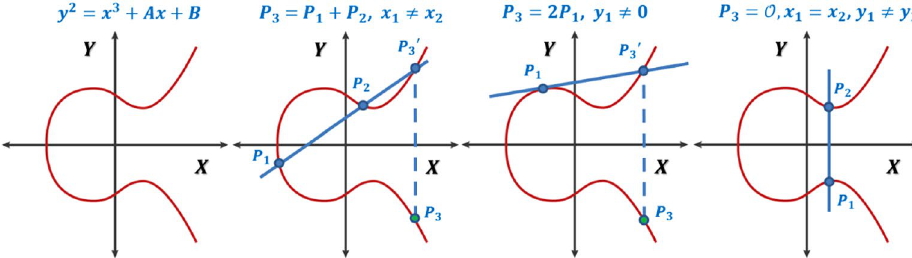
Figure 1. Example EC and the first three cases for point addition.